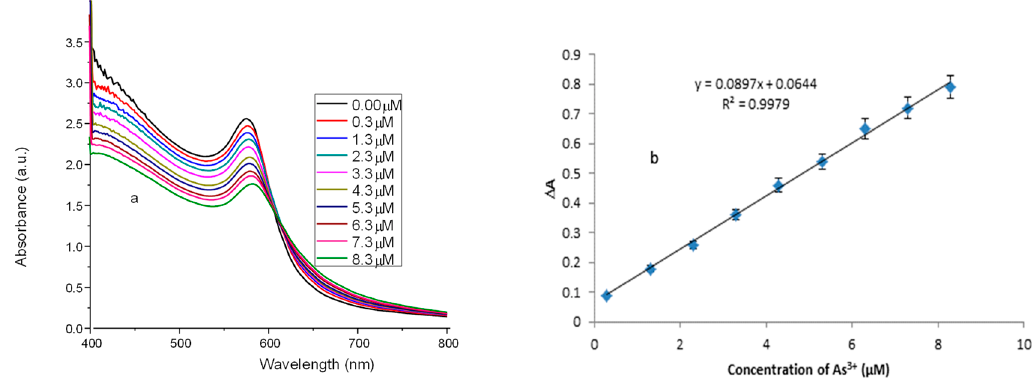
Figure 5. ( a ) Decrease in absorbance with increasing concentration of As 3+ . ( b ) Linear regression plot between ∆ absorbance and As 3+ concentration. Table 1. Comparison of reported methods with ranolazine-functionalized Cu NP sensor for detection of As 3+.